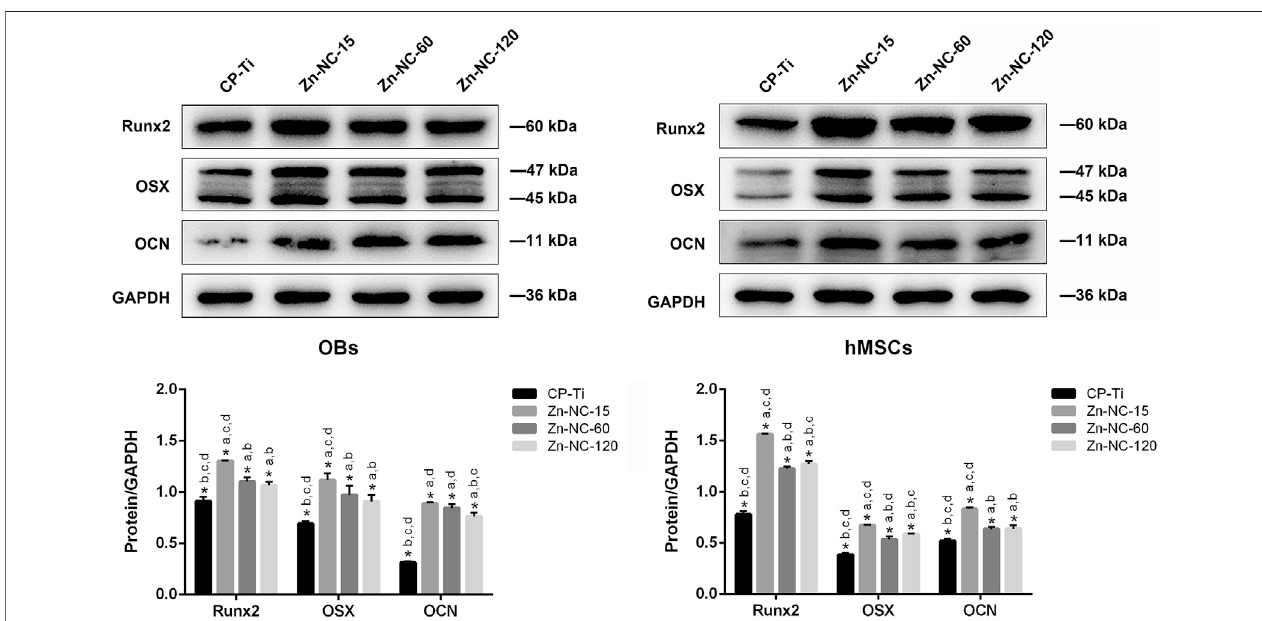
FIGURE 11 | Expression of osteogenesis-related proteins, Runx2, OSX, and OCN, in OBs and hMSCs cultured for 7 days on the different surfaces (n (cid:2) 3). * p < 0.05; a P < 0.05 vs. CP-Ti; b P < 0.05 vs. Zn-NC-15; c P < 0.05 vs. Zn-NC-60; d P < 0.05 vs. Zn-NC-120.